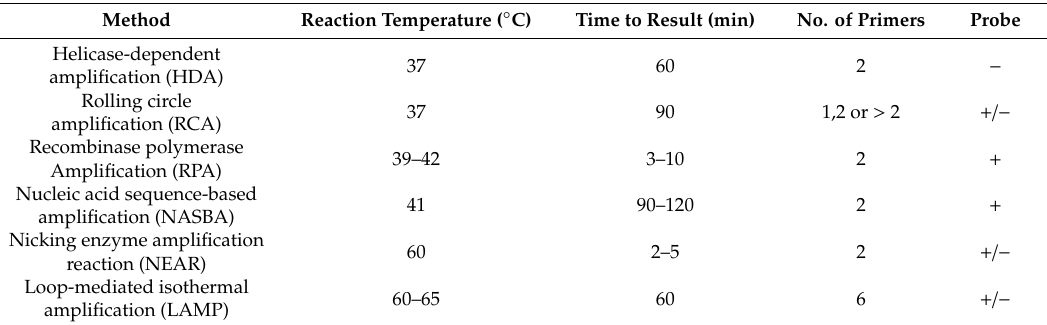
Table 3. Di ff erent Isothermal Amplification Techniques.